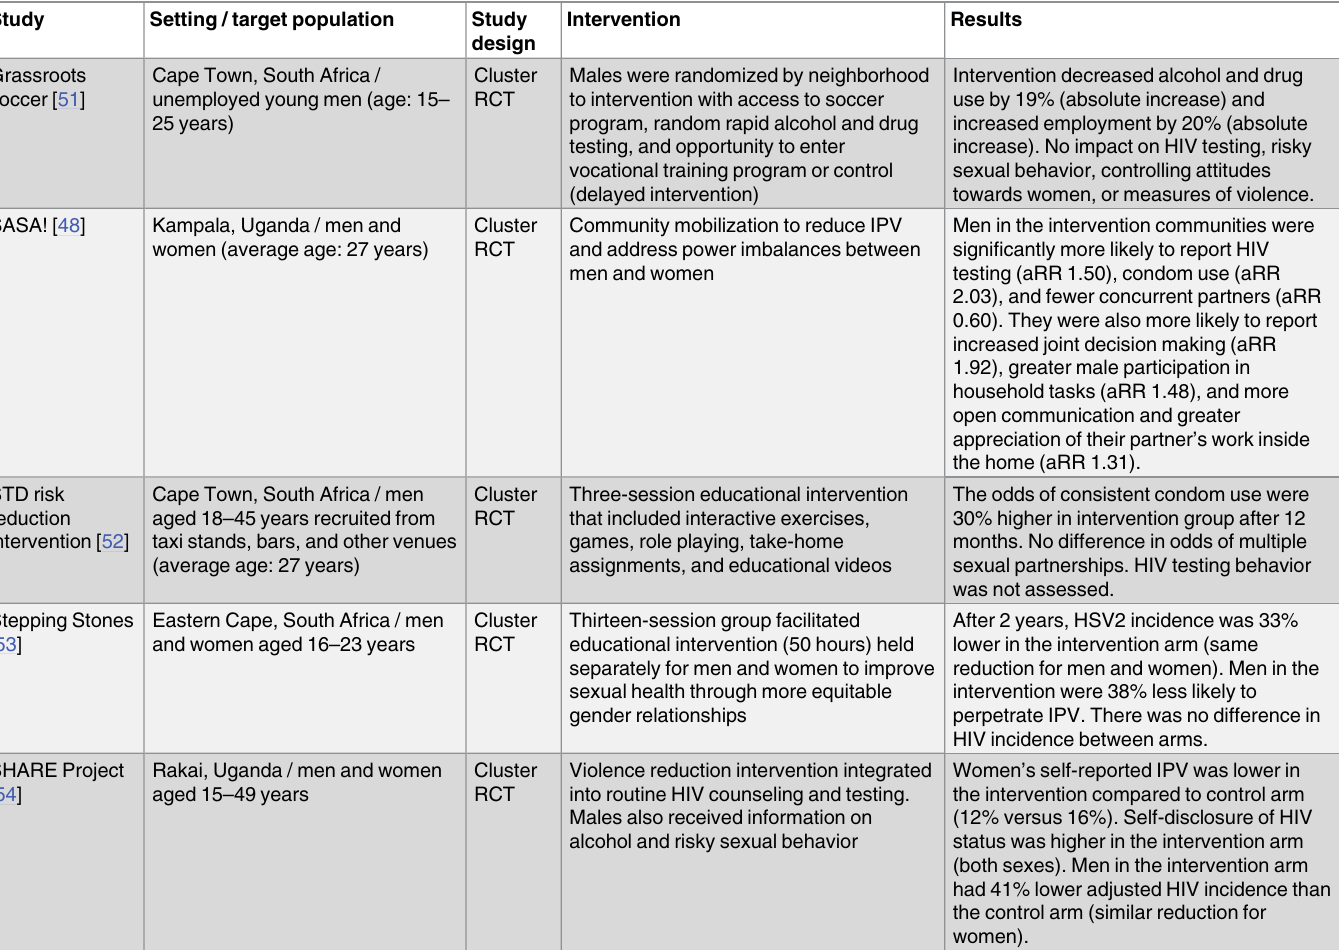
Table 2. Community-based educational initiatives for HIV